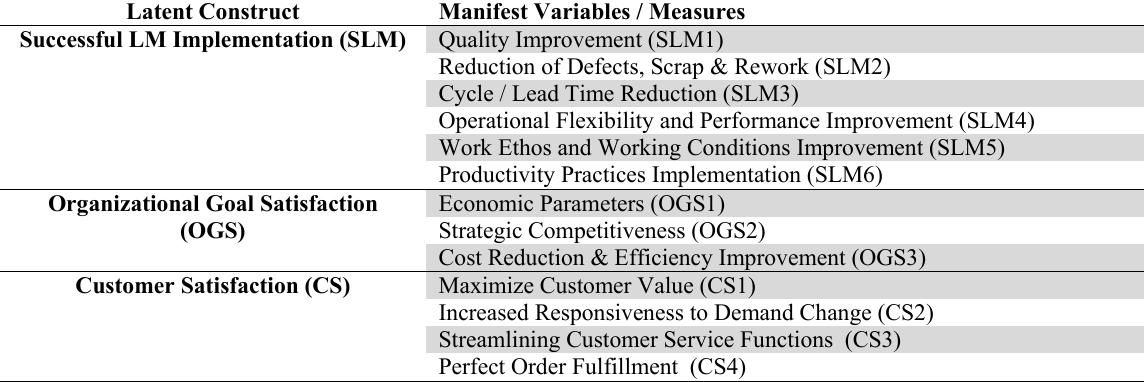
Output Manifests and Latent Constructs of successful LM implementation Latent Construct Manifest Variables / Measures Successful LM Implementation